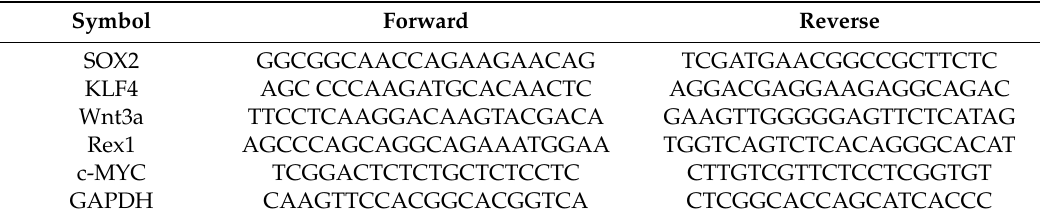
Table 1. Primer sequences used for